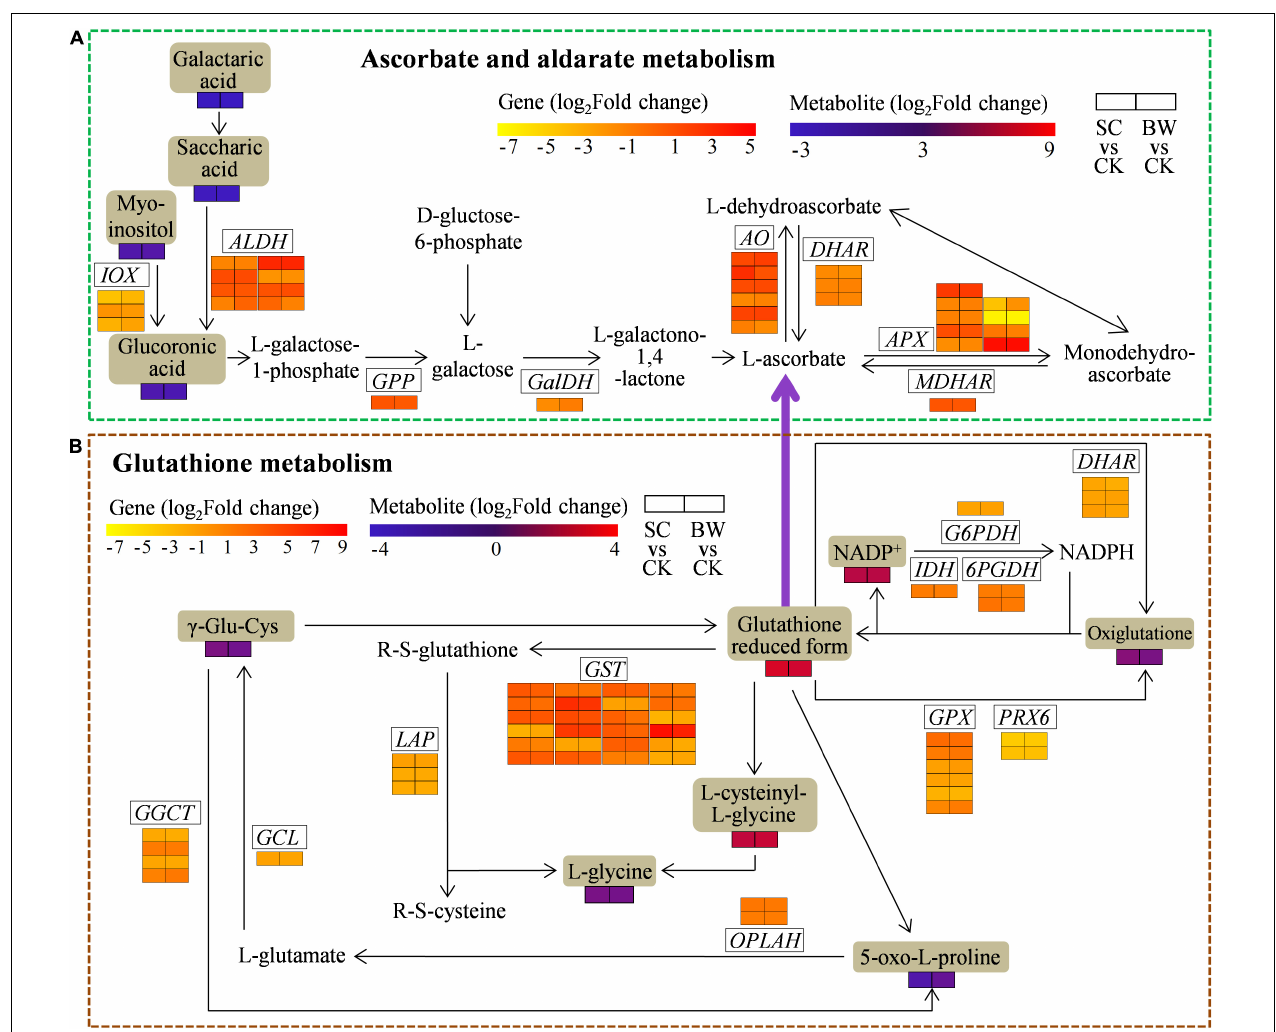
FIGURE 6 | The DEGs and DAMs involved in (A) ascorbate and aldarate metabolism and (B) glutathione metabolism during the seed initial imbibition under salt stress. The brown background indicated the DAMs that changed under salt stress. The rectangular color block was equally divided into two parts, of which the left represented DEGs or DAMs in SC vs. CK and the right represented DEGs or DAMs in BW vs.